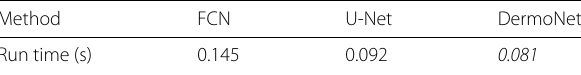
Table 3 Comparison of average runtime (s) per image Method